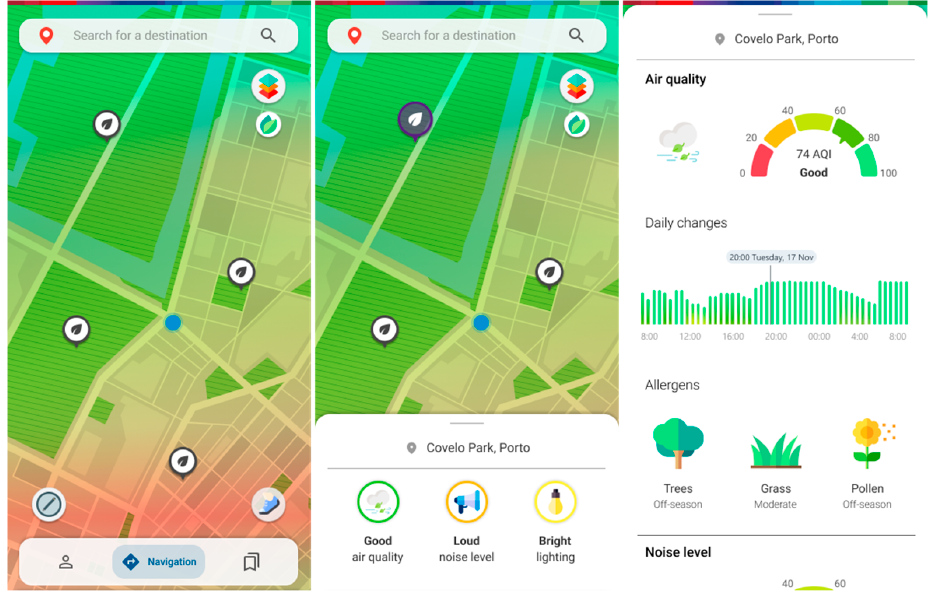
Figure 7. Screens for air quality, noise level and lighting level section, with heatmap and further information.